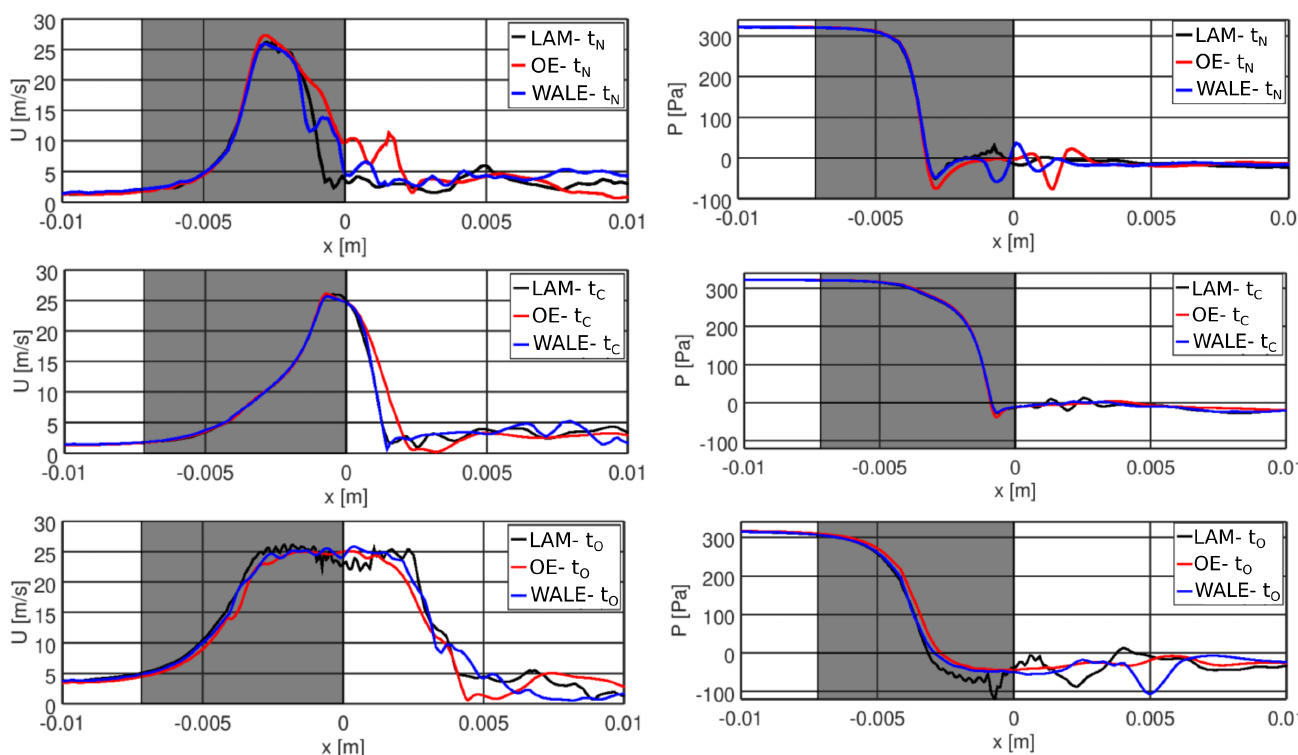
Figure 3. Velocity magnitude ( left ) and pressure distribution ( right ) along the glottal mid–line in three time instants t N ( top ), t C ( middle ) and t O ( bottom ). Gray background denotes the region of the moving vocal folds.